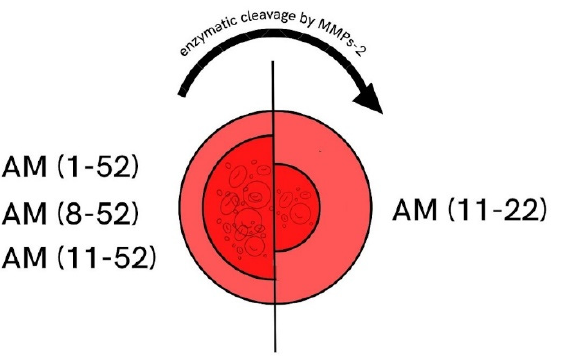
Figure 4. MMP-2 cleavage of AM. Adrenomedullin (AM 11–52) is a peptide that affects vessels and leads to its vasodilation. MMP-2 regulates BP by reducing the AM (1–52, 8–52, and 11–52) into smaller peptides AM (11–22), which act as vasoconstrictors. Therefore, MMP-2 may worsen vascular function and increase BP in hypertensive patients. Numbers in brackets are the peptide length before and after the MMP2 cleavage. MMP-2, matrix metalloproteinase 2; AM, adrenomedullin; BP, blood pressure.